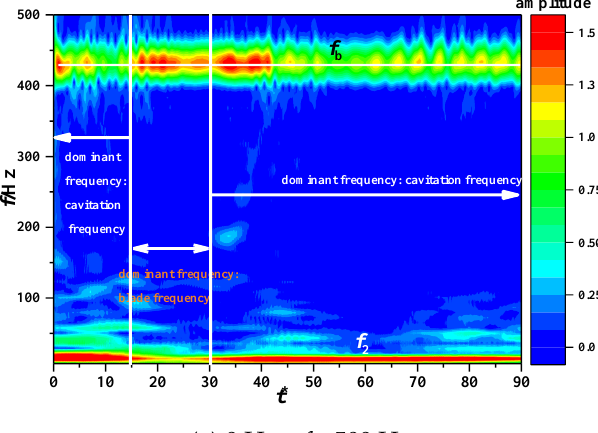
Figure 20. The wavelet transform spectrum of 70 °C.